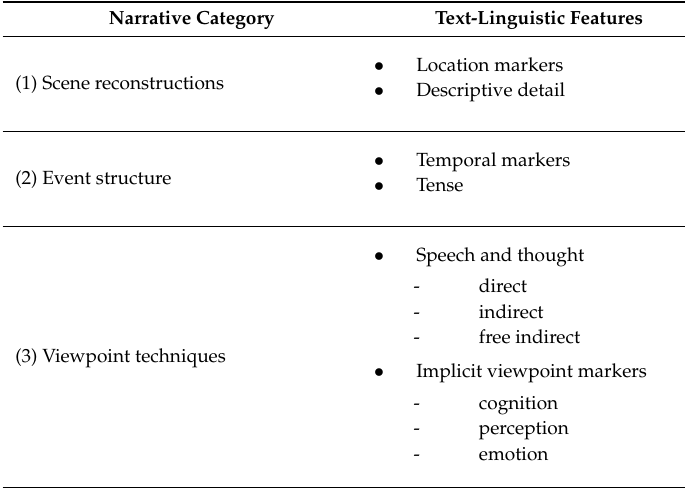
Table 1. Text-linguistic features of the three main narrative